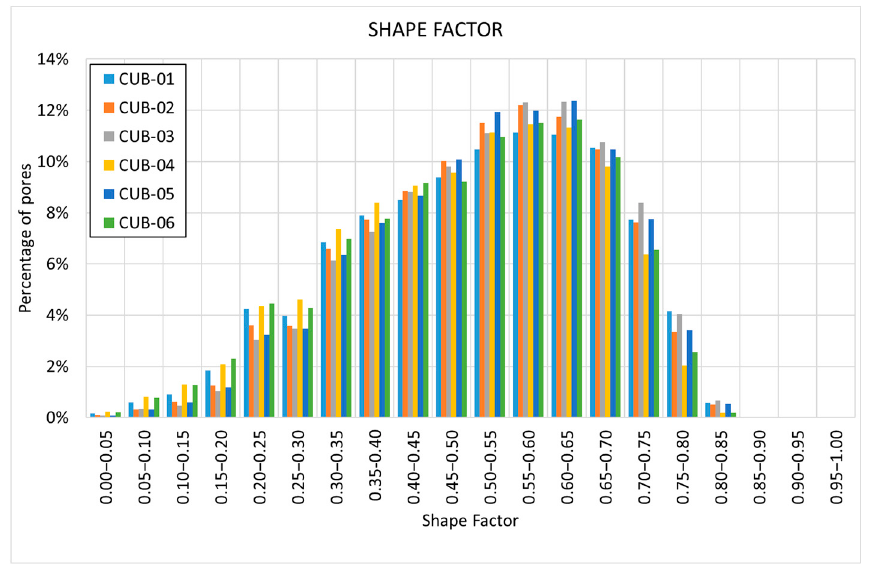
Figure 24. Histogram of the shape factor.